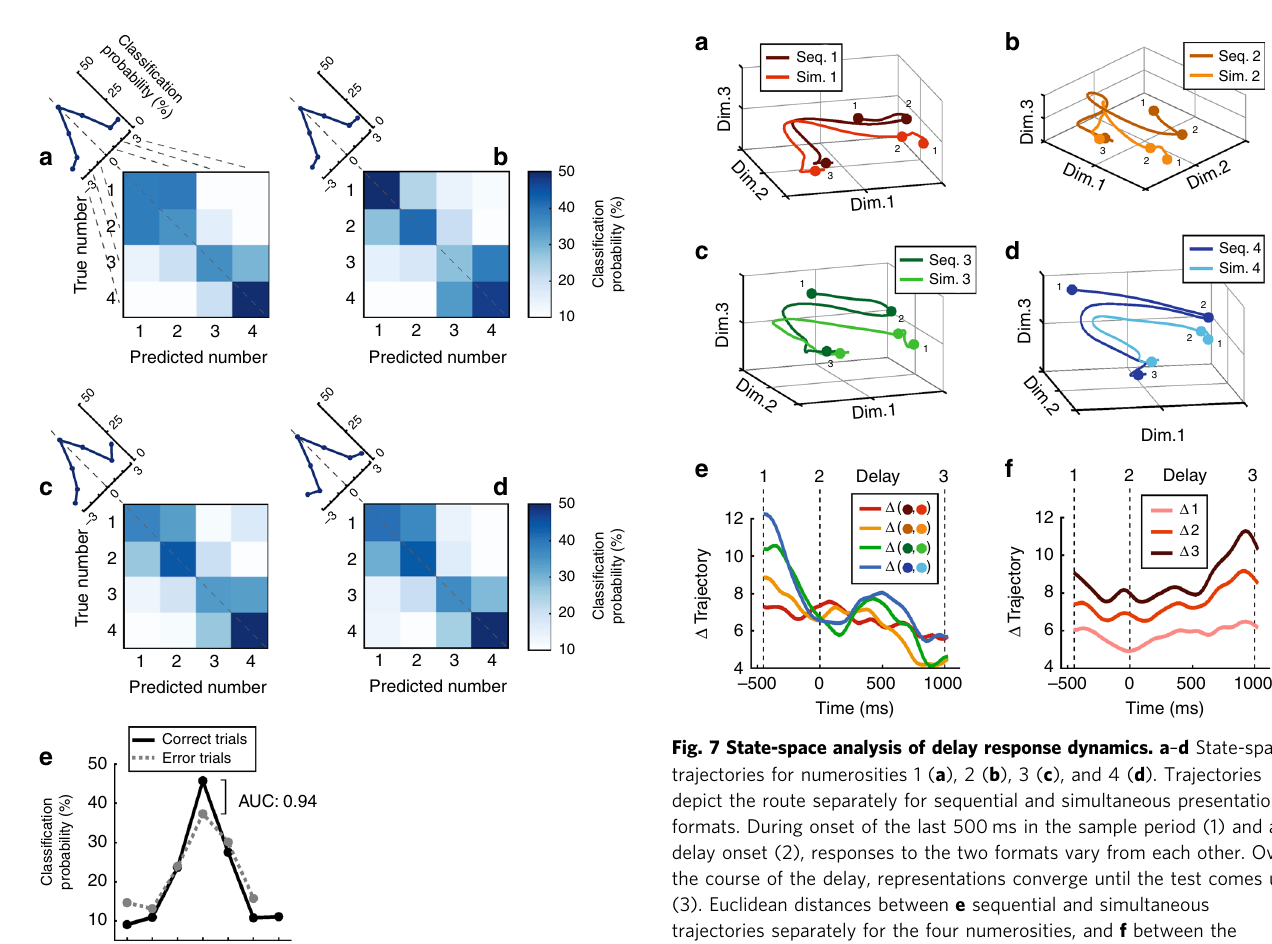
accuracies for both formats was comparable (Fig. 6a, b) (sequential: 43.1% ± 5.5, standard deviation; simultaneous: 41.9% ± 4.3). The classi fi er trained on the sequential format pre- dicted the correct numerosity in the simultaneous format with an accuracy of 42.8% (±3.8) (Fig. 6c), and signi fi cantly above chance level of 25%. Similarly, the classi fi er trained on the simultaneous format predicted the correct numerosity in the sequential format with an accuracy of 44.5% (±3.9) (Fig. 6d) (the 5th percentile for both classi fi ers was above the 95th percentile of their respective shuf fl ed distribution). Based on the similar accuracies of